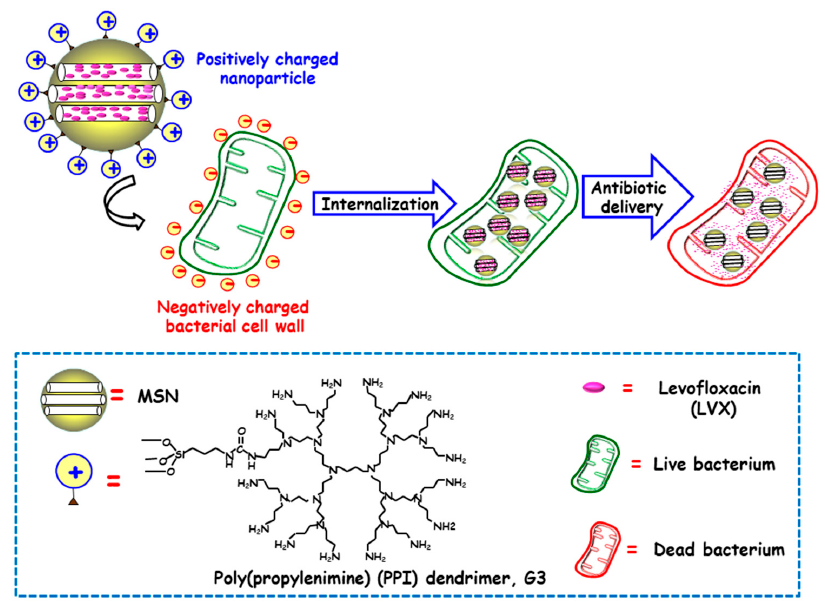
Figure 2. Schematic illustration of the mechanism of action of Gram negative ( E. coli ) bacteria-targeted antimicrobial nanosystems consisting of MSNs loaded with levofloxacin (LVX) and functionalized